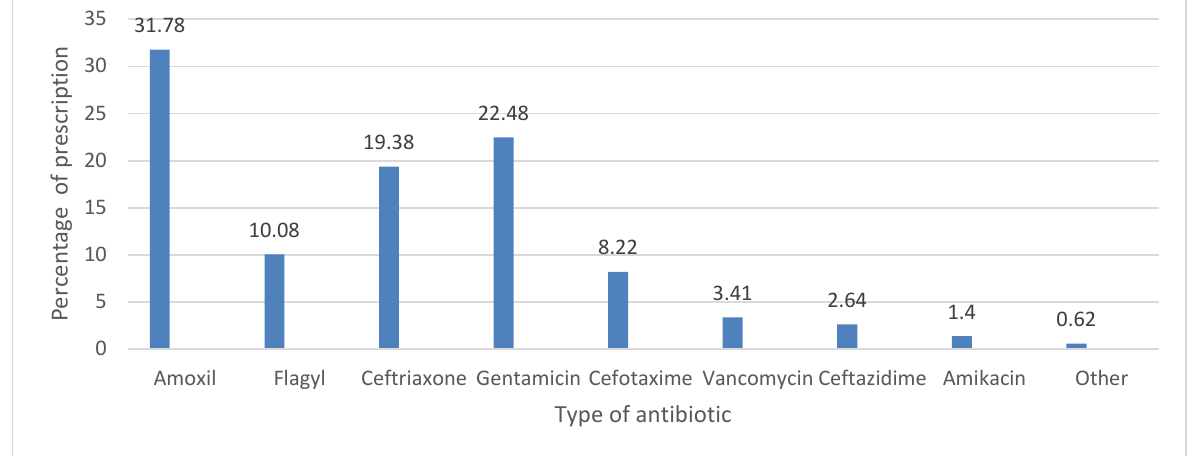
Figure 3: Single antibiotics prescribed in inpatient department (Total